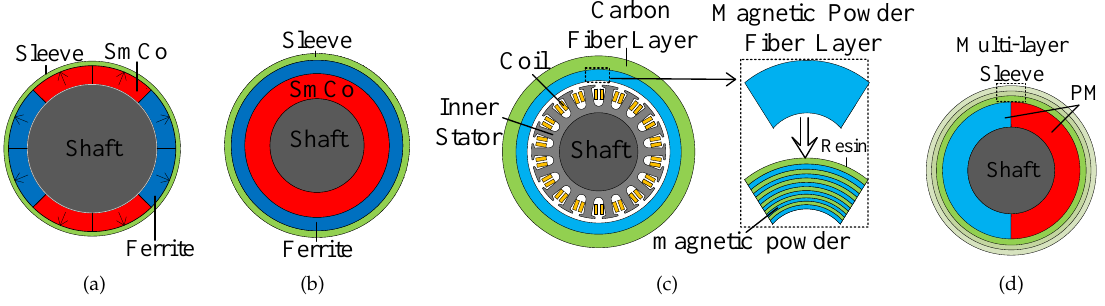
Figure 11. Rotor structures of high-speed PM motor with sleeves: ( a ) Circumferential composite excitation structure; ( b ) Radial composite excitation structure; ( c ) Magnetic powder fiber composite rotor structure; ( d ) Multi-layer sleeve mating structure.